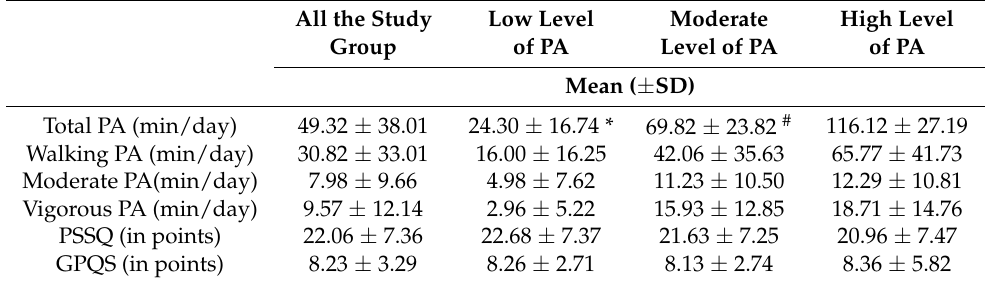
Table 3. Time of physical activity, level of stress and quality of sleep in the study population ( n = 1956) according to the level of PA.